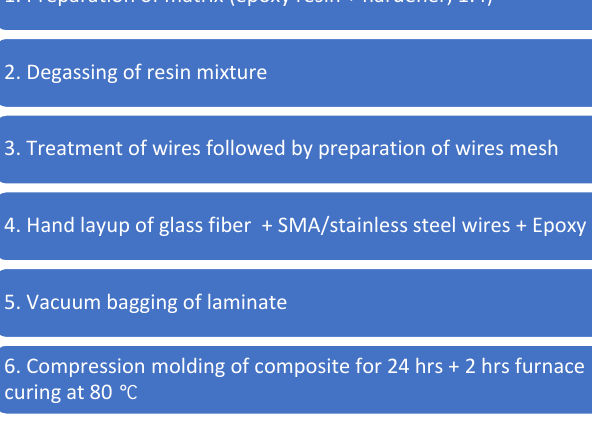
Figure 2. Manufacturing sequence of hybrid SMA/FRP composite.